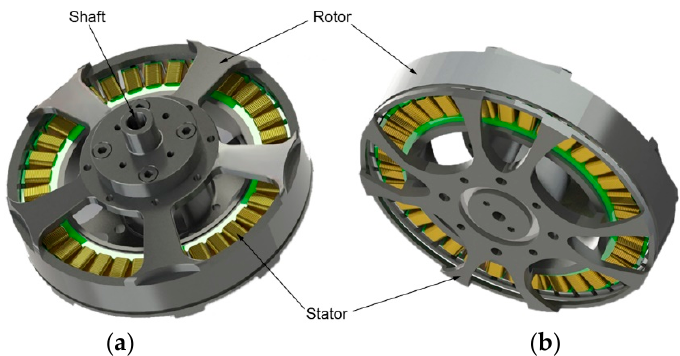
Figure 5. Conceptual graph of the U7 KV170 motor produced by T-MOTOR: ( a ) Front; ( b ) Back.